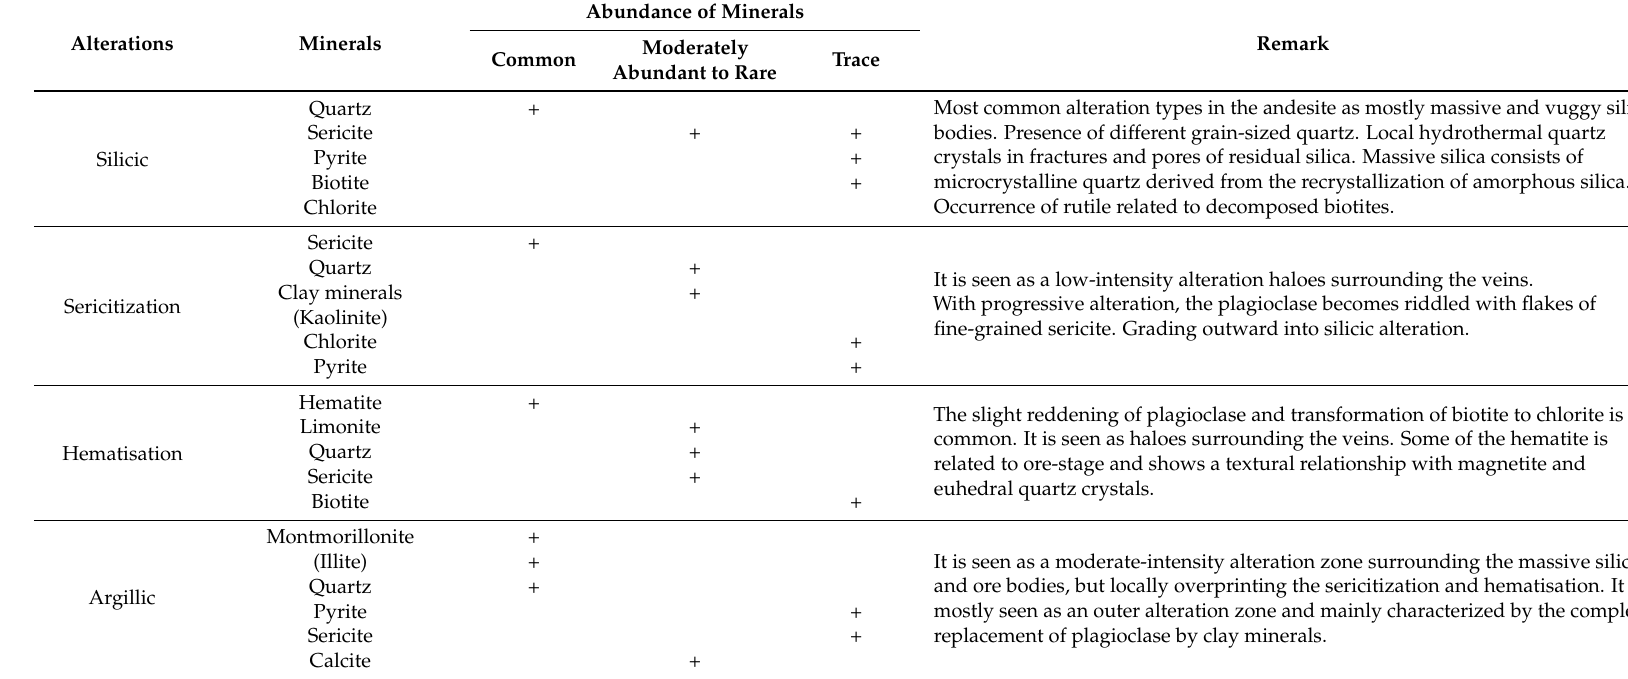
Table 1. Mineralogy of the different types found at